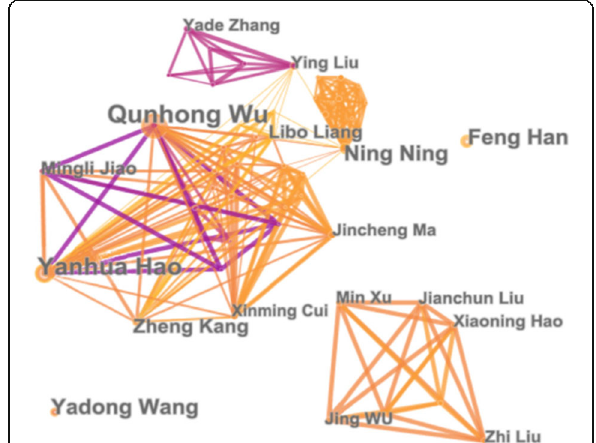
Fig. 4 Co-author network of Chinese database. Different colors represent different time slices. The size of node represents the number of articles by the author. The link strength between two nodes means the collaboration intensity between